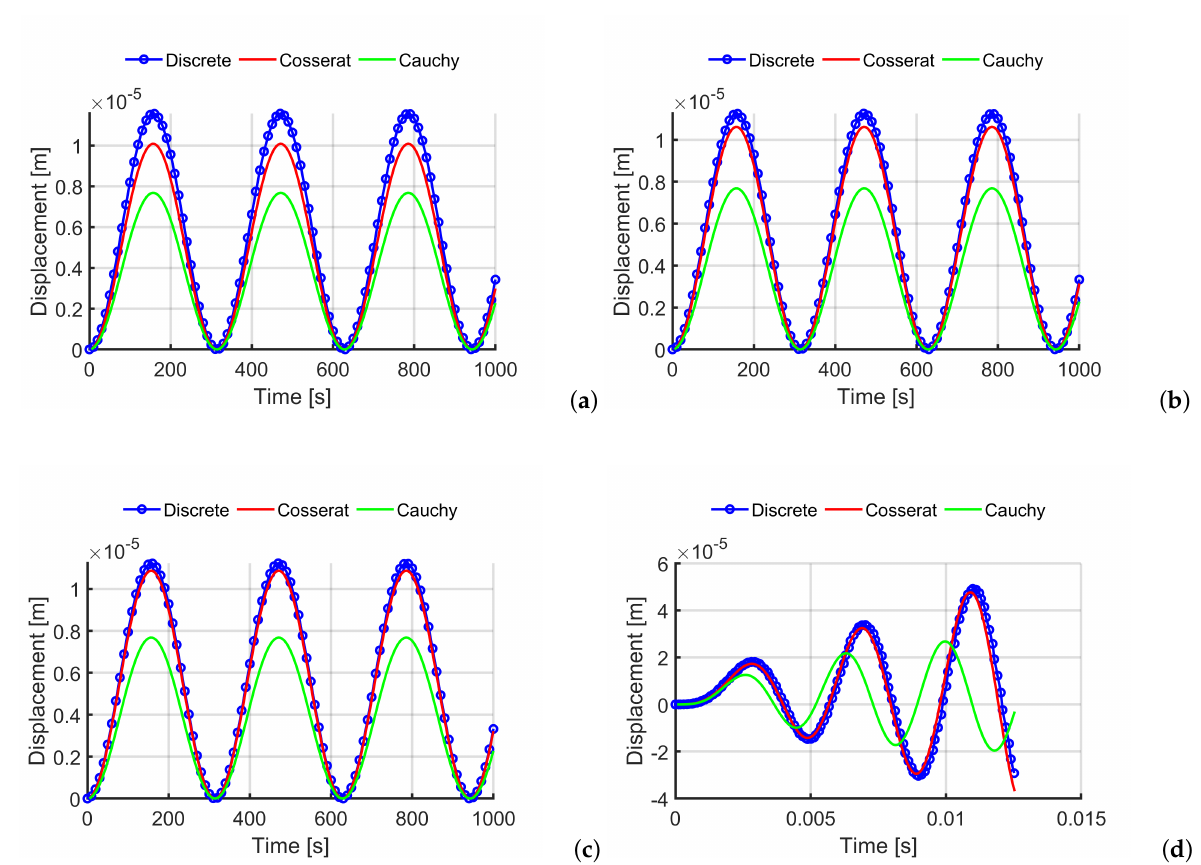
Figure 4. Time-history analysis for texture 1: horizontal displacements for the three texture scales ( a ) s = 1 ( b ) s = 0.5 ( c ) s = 0.25 (load case 1) ( d ) mechanical resonance for the scale s = 0.5 (load case 2).